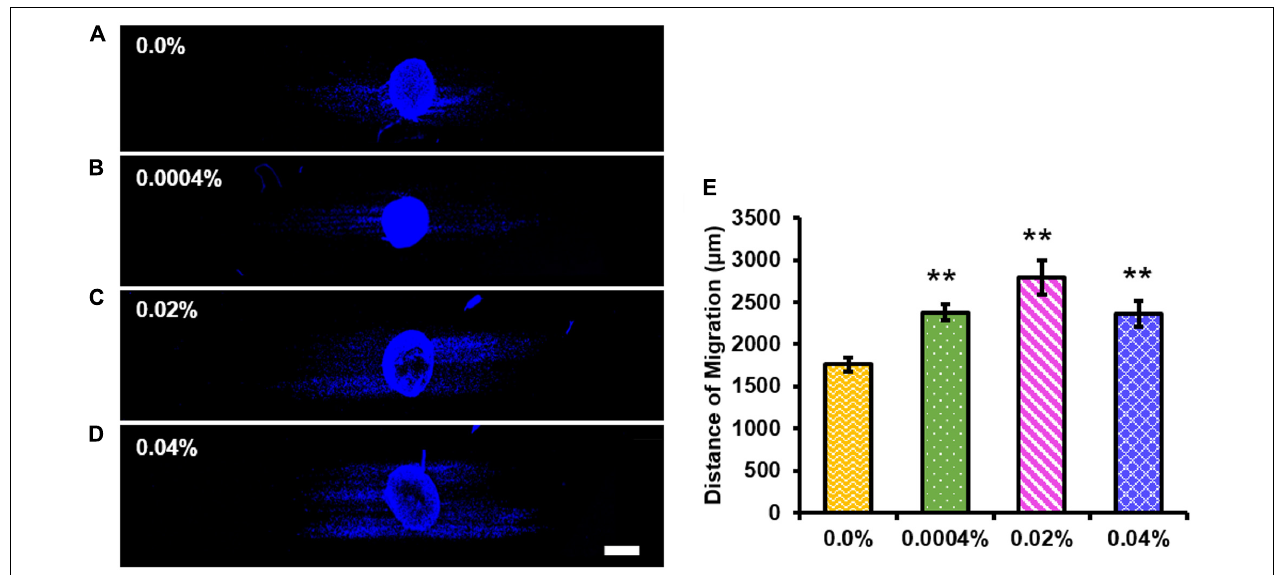
FIGURE 7 | All fingolimod-loaded electrospun fiber groups significantly increased Schwann cell migration outward from the dorsal root ganglia (DRG) body. Confocal images of whole DRG stained with 4 (cid:48) ,6-diamidino-2-phenylindole and cultured on (A) 0.0%, (B) 0.0004%, (C) 0.02%, or (D) 0.04% fingolimod-loaded poly(lactic-co-glycolic acid) electrospun fibers (scale bar = 500 µ m). (E) The migration distance data for each fiber group are represented by the mean distance traveled from the DRG body ± the standard error of the mean. Statistical significance compared with the 0.0% control fibers was assessed for Schwann cell migration distance using one-way ANOVA and post hoc Dunnett’s test (** p <